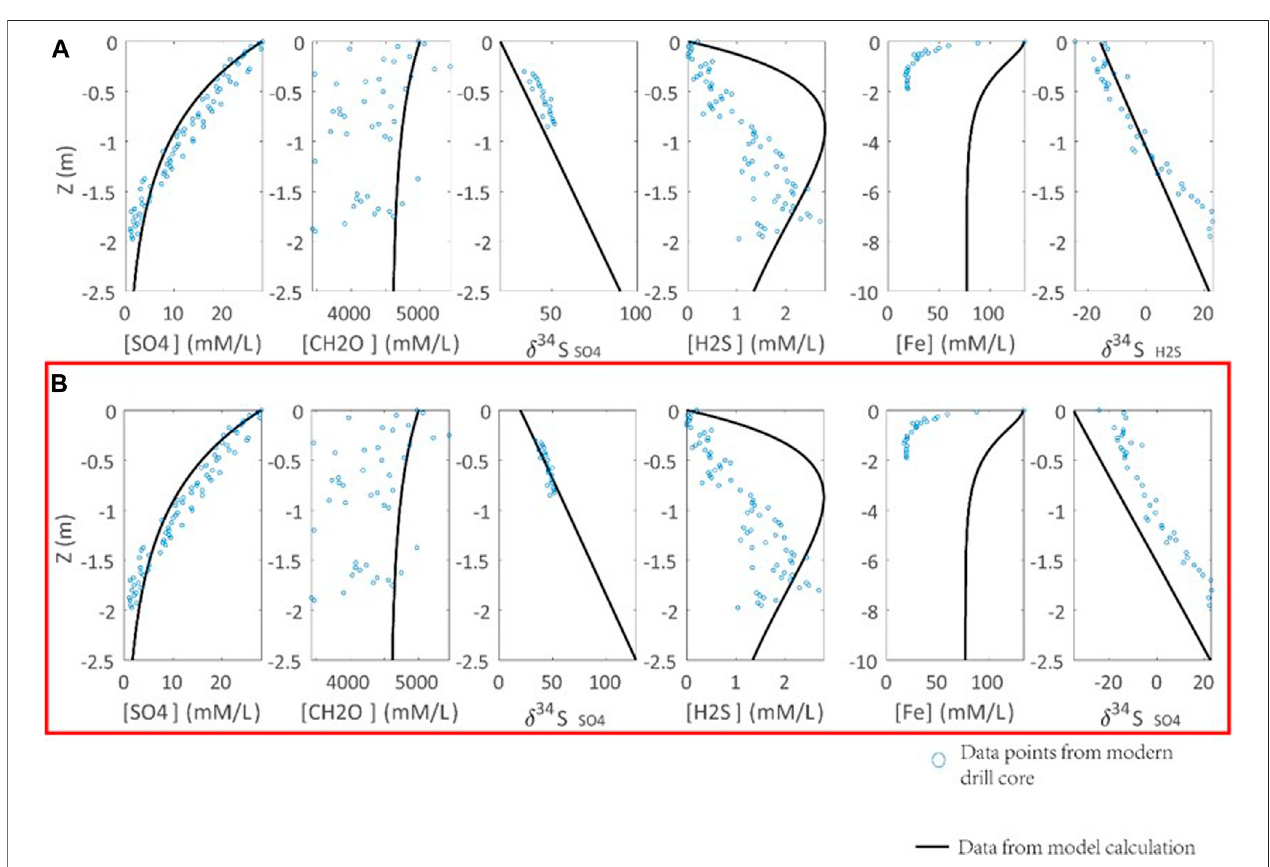
FIGURE 4 | Calibration of the S isotope fractionation in DSR ( Δ DSR ) with observations from modern marine sediments (Soutar and Crill, 1977; Raven et al., 2016). Parameters of calculations are R py (cid:1) 0.3 [(mM/L)*ka] − 1 , R DSR (cid:1) 0.0033 [(mM/L)*ka] − 1 . Δ DSR is set to (A) 46 ‰ , (B) 70 ‰ . Blue points are the modern sediment samples. The black lines are the modeling results. Δ DSR (cid:1) 70 ‰ in (B) can simulate the sulfate pro fi les in modern marine sediments (highlighted by the red box).